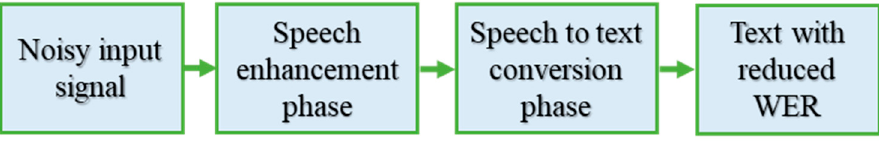
Figure 1. Proposed idea.